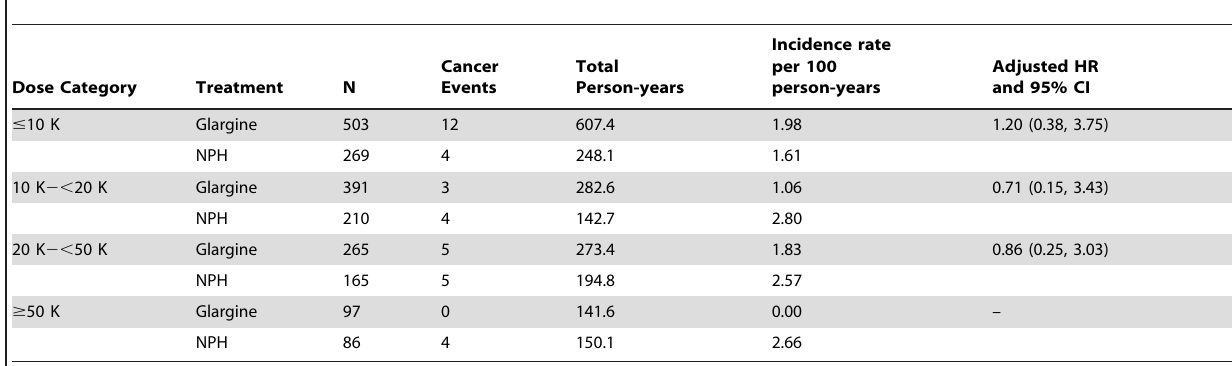
Table 3. Association between long-acting insulin use and cancer for new users by dose category (As-Treated Analysis).